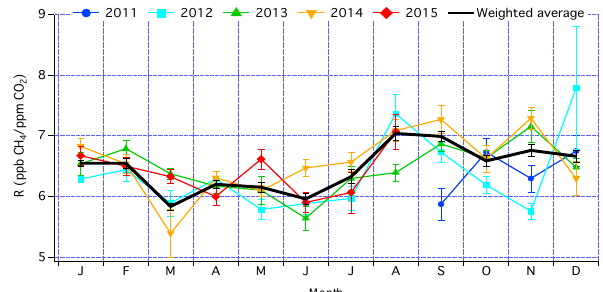
Figure 3. Monthly patterns of the Los Angeles Basin weighted- average regression slopes of X CH 4 (XS) – X CO 2 (XS) (in unit of ppbppm − 1 ) and their uncertainties observed by the CLARS-FTS in the basin. Monthly trends are color-coded as follows: 2011 in blue, 2012 in cyan, 2013 in green, 2014 in orange, and 2015 in red. The monthly average ratio and its standard deviation over the entire observational period are shown in